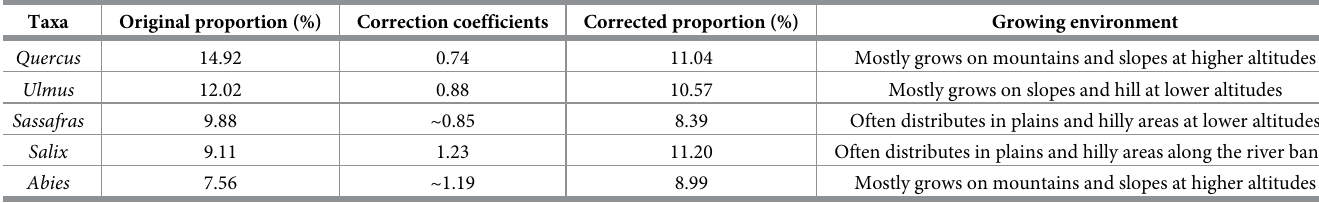
Table 4. Genera correction and its growth environment from Huiduipo